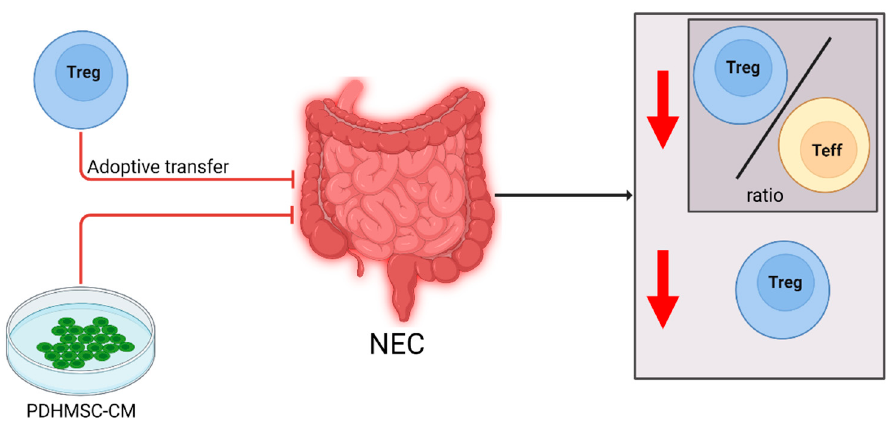
Figure 3. Cellular changes observed in NEC patients and experimental animal models and the effect of immune modulating interventions. After NEC diagnosis or induction, the Treg/Teff cell ratio and overall Treg levels were decreased (downward arrow). Supplementation of PDHMSC-CM negated the decrease in Tregs, improving the immune regulation, and reduced development of NEC in a rat model. Adoptive Treg-transfer reduced NEC development in a mouse model.